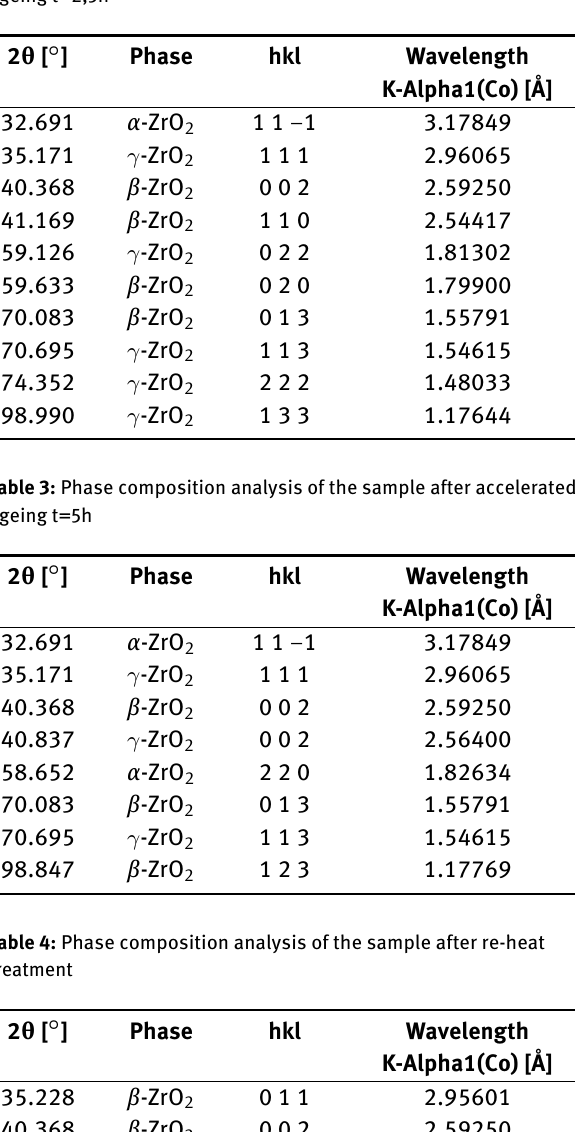
Table 2: Phase composition analysis of the sample after accelerated